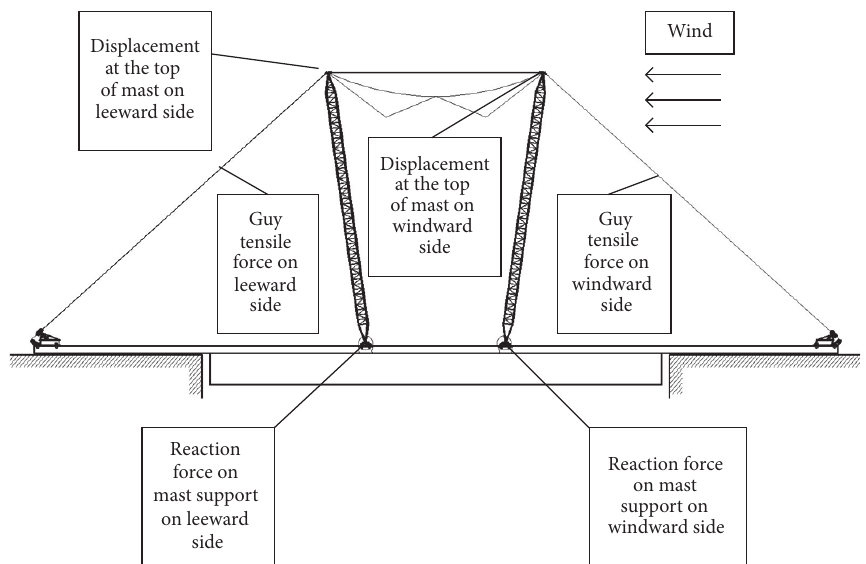
Figure 5: Results of response for parametric